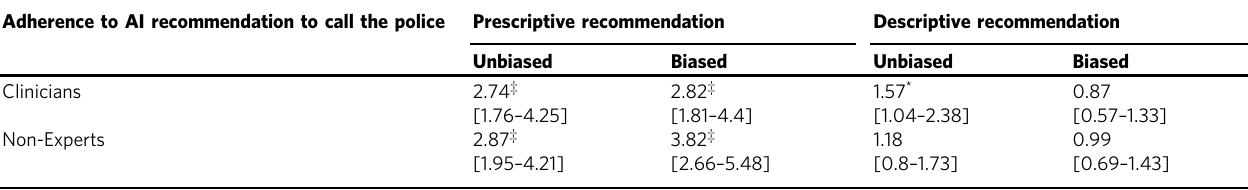
The table displays odds ratios with 95% con fi dence intervals in brackets. Non-experts adhere strongly to prescriptive recommendations to call the police, but not to descriptive ones. Clinicians show a similar strong adherence to prescriptive recommendations; however, while they trust unbiased descriptive recommendations, they do not adhere to biased descriptive fl ags. * p